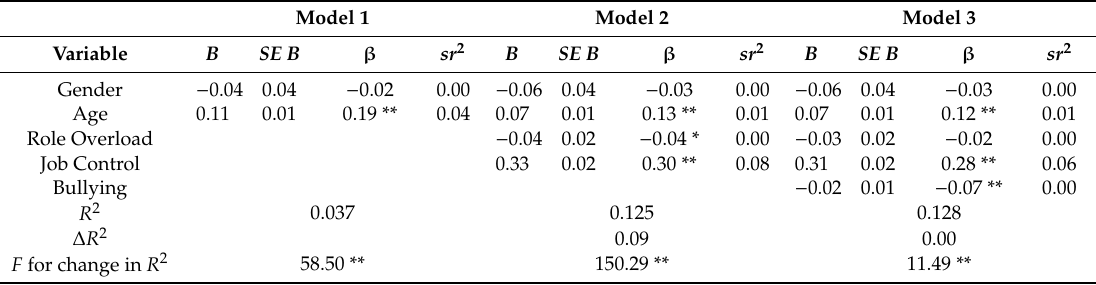
Table 3. Summary of hierarchical regression analysis for variables predicting a ff ective commitment ( n =